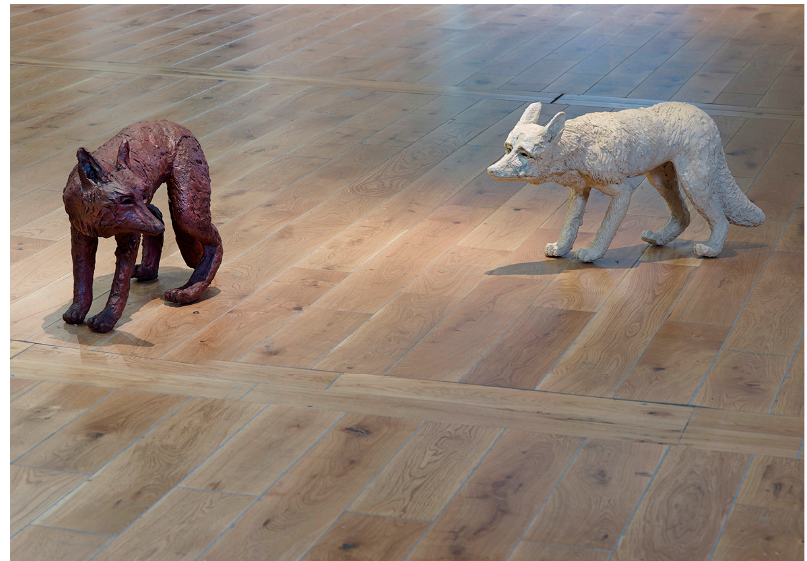
Figure 11. Foxes (2022), Fieldnotes , HOME, Manchester. Ceramic, various sizes. Photograph by Michael Pollard.